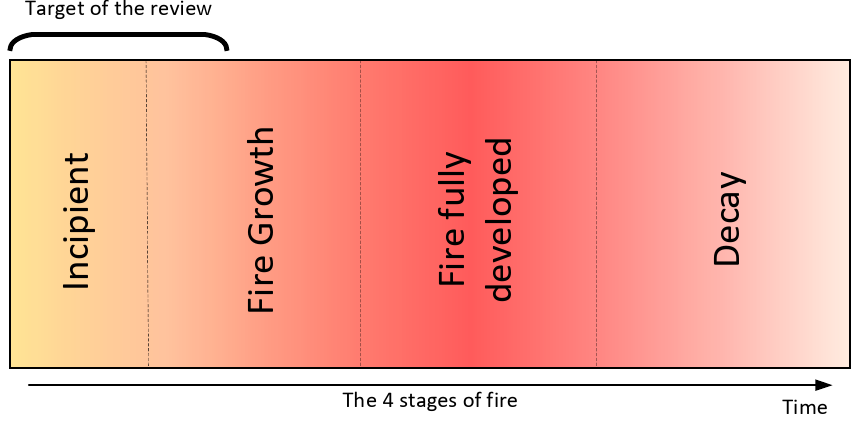
Figure 2. Systems discussed in this review target the detection of fire in the early stages of the fire cycle.